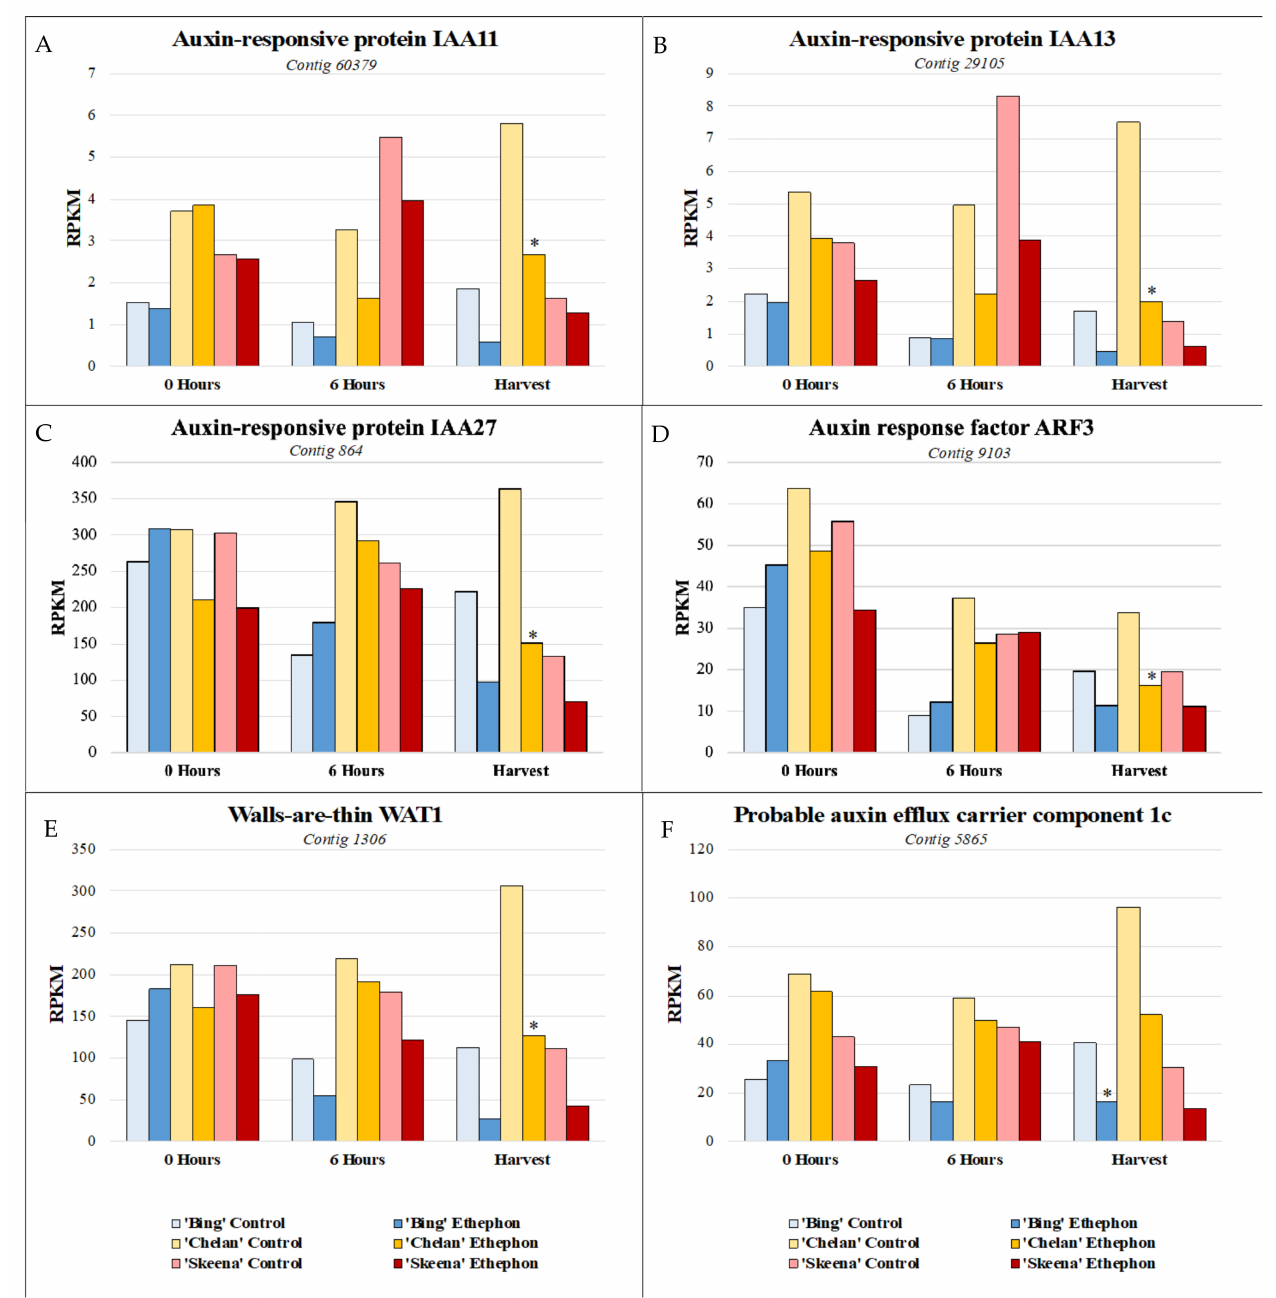
Figure 6. Expression patterns of auxin-associated genes. ( A ) shared expression pattern was observed for auxin-associated genes at harvest. Auxin-responsive transcription factors IAA11 , IAA13 , and IAA27 ( A – C ), auxin transport facilitator walls-are-thin 1 ( WAT1 ) ( E ), and auxin efflux carrier component 1c ( F ) displayed comparatively lower expression in ‘Skeena’, intermediate expression in ‘Bing’, and higher expression in ‘Chelan’ control at harvest. Following ethephon treatment, expression was attenuated in all three cultivars; however, the same relative expression trend was maintained, with ‘Skeena’ ethephon-treated fruit exhibiting lowest expression at harvest and ‘Chelan’ ethephon-treated fruit displaying the highest expression at harvest. Asterisks indicate significant difference, according to both Kal’s Z-test ( p < 0.05) and NOIseq-sim differential expression probability analysis (probability > 0.8), and a |logFC| >